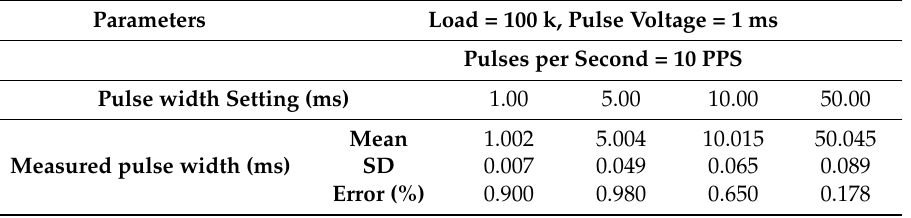
Table 2. Error estimation of the electroporation on generating electric pulses with specific pulse